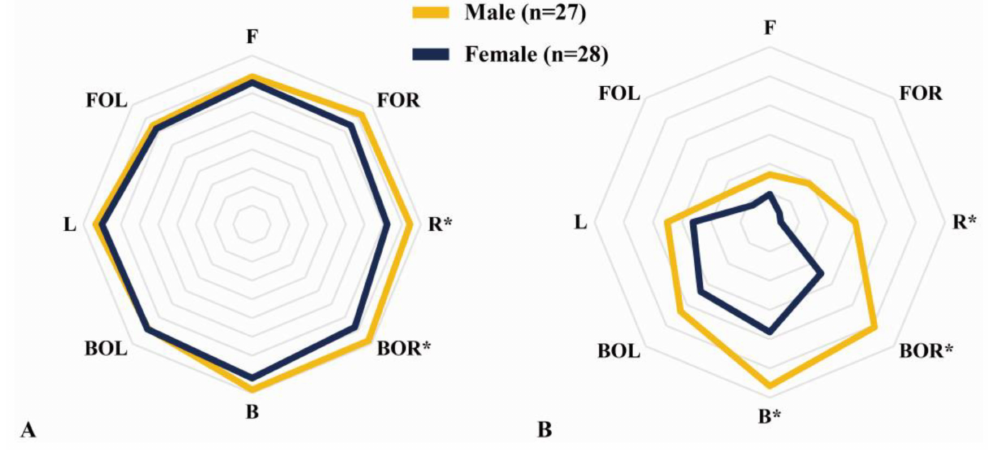
Figure 6. Subanalysis of core muscle asymmetry according to the difference between the males and females. ( A ) Direction core muscle ratio (DCMR). ( B ) Core muscle state ratio (CMSR). Analysis through independent-samples t-tests. * Significant differences between the groups ( p < 0.05).